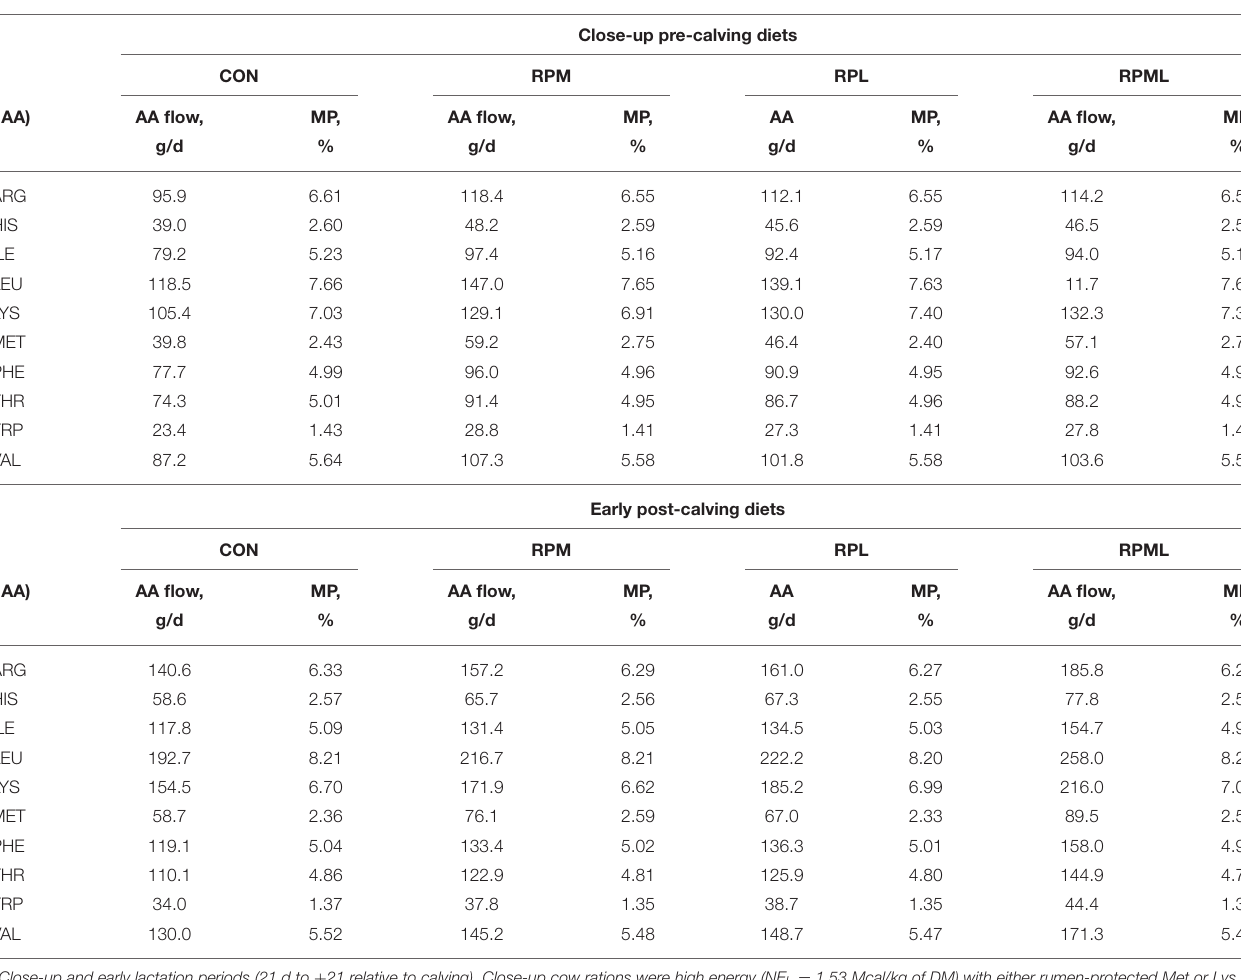
TABLE 3 | Duodenal flows of the digestible indispensable amino acids (IAA) predicted for diets fed during the transition period by the Cornell Net Carbohydrate and Protein System [(CNCPS) v. 6.5.5] a